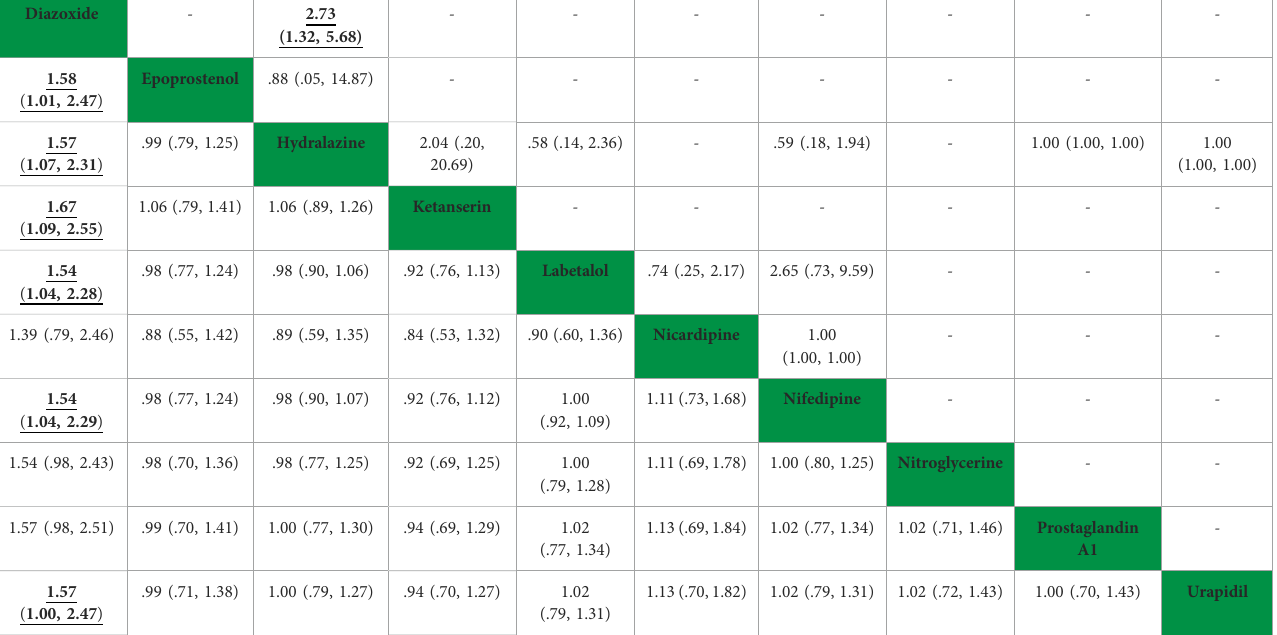
TABLE 2 Network comparison and direct comparison results for the rate of achieving target blood pressure (mmHg). Diazoxide